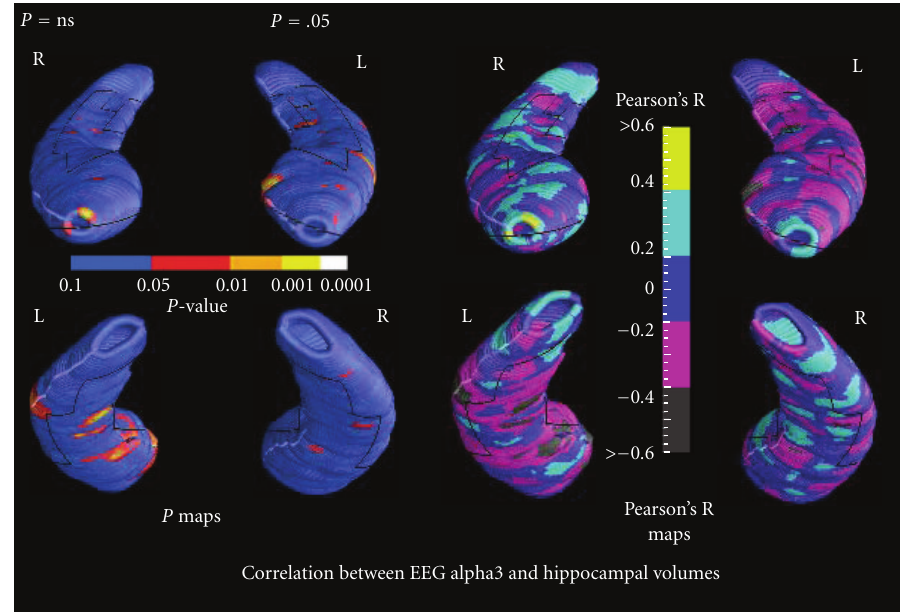
Figure 2: Correlation between alpha3 power rhythm and volumes of hippocampal subregions in AD patients. Permutations overall P values are displayed on top of each